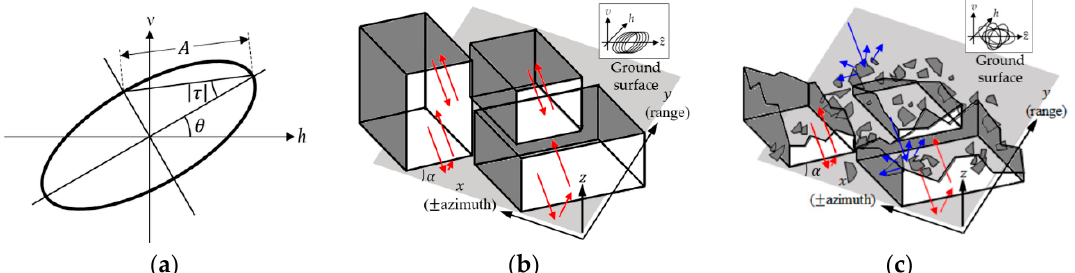
Figure 1. ( a ) Polarization ellipse; ( b ) Illustration of the polarization orientation angle (POA) in a built-up area for oriented buildings; and ( c ) Illustration of the POA changes in a built-up area for damaged buildings. Red lines indicate the reflections from the walls with the rotation angle α along the azimuth direction. Blue lines indicate the reflections from damaged parts of buildings.